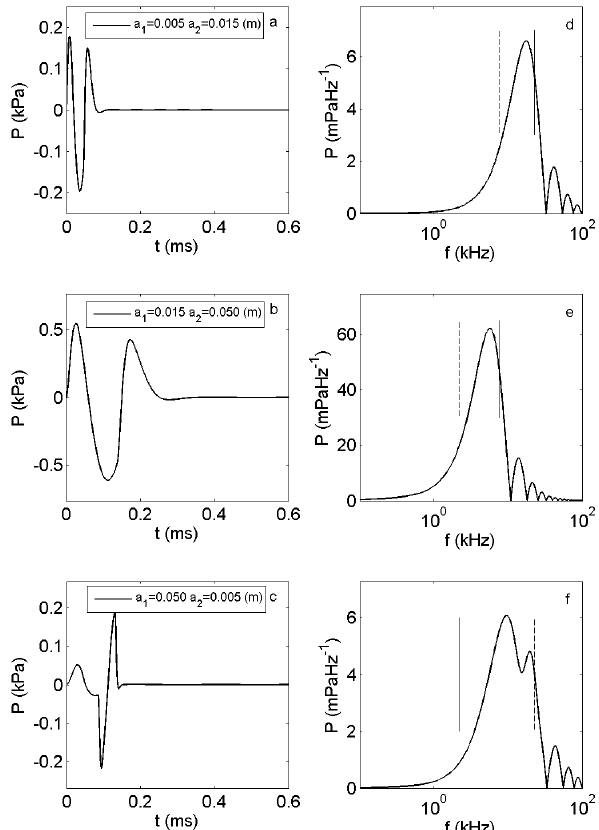
Figure 4. Calculations for glass spheres of different sizes impact- ing. (a) – (c) Time domain waveform calculated using Eq. (1) and (d) – (f) frequency spectrum calculated using Eq. (2). The vertical lines are the location of the peak frequencies for spheres of equal size impacting have respectively radii of the impactee, a 1 (-), and the impactor, a 2 (-